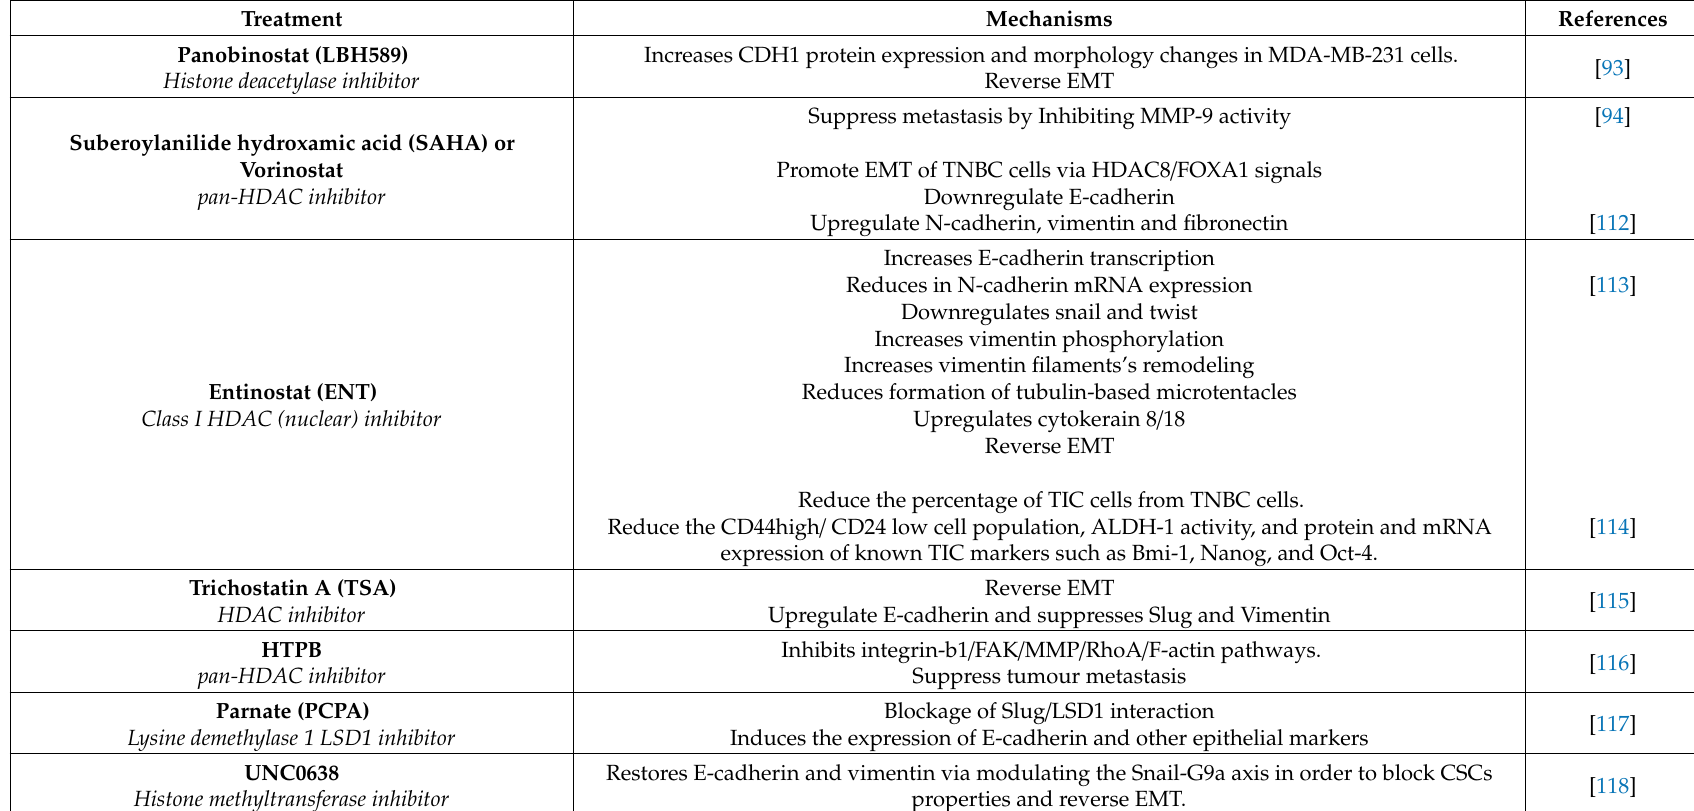
Table 4. Role of histone modification